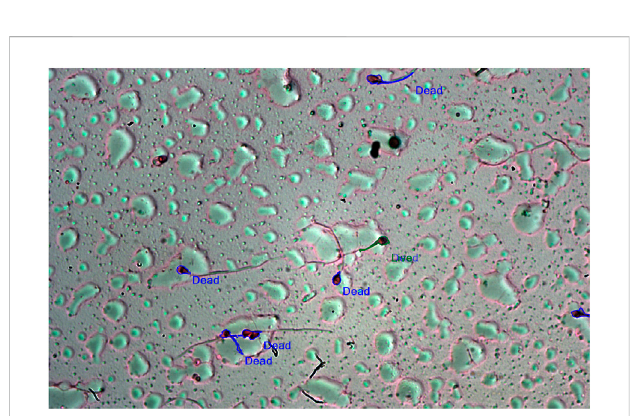
FIGURE 3 (Left) Image from the vitality test for 100 μ g/ml AMLE using the eosin staining method. The blue region indicates the presence of dead sperm cells after the application of 100 μ g/ml AMLE. This may be due to the effect of AMLE on acrosomal and cytoskeletal proteins such as hyaluronidases.